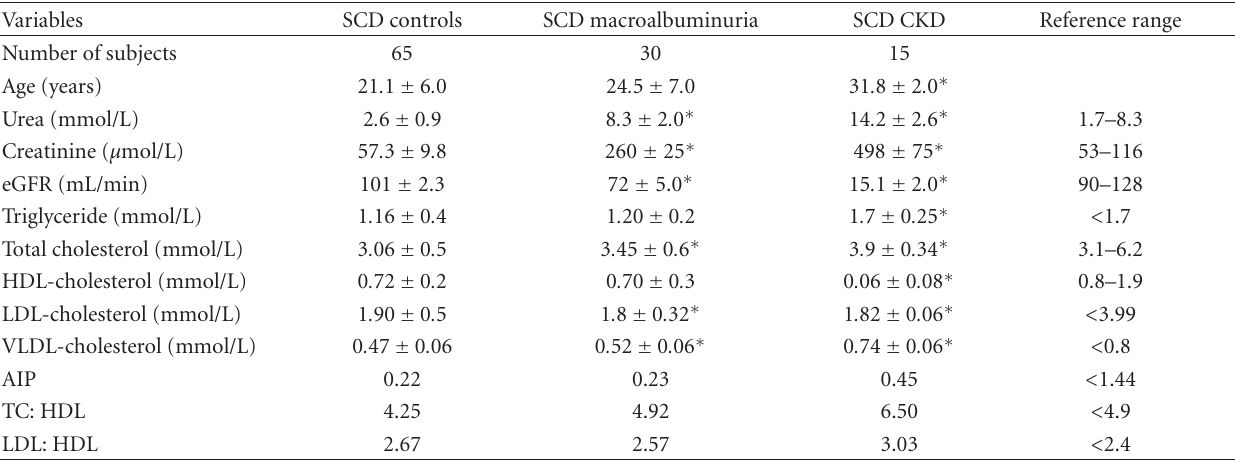
Table 1: Biochemical and lipid profile of sickle cell disease controls, macroalbuminuria, and chronic kidney